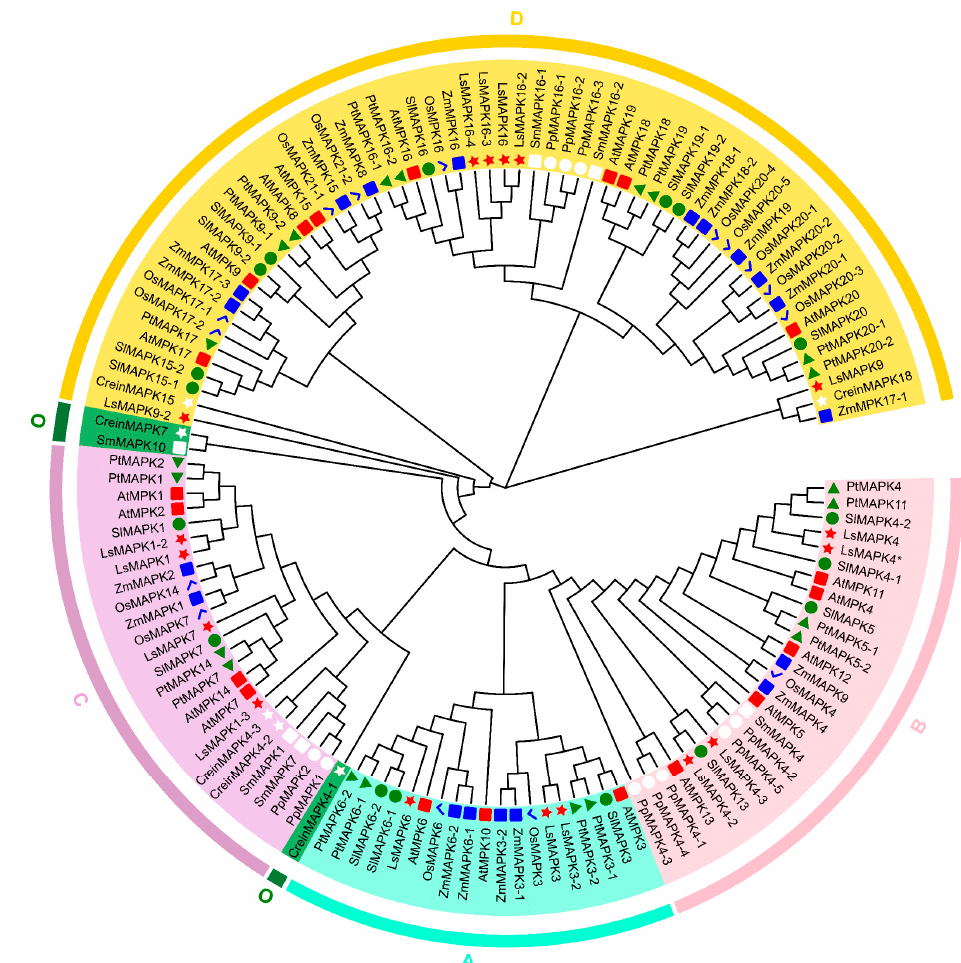
Figure 3. Phylogenetic relationships of the MAPK gene family from Physcomitrella patens ( PpMAPKs ), Chlamydomonas reinhardtii ( CreinMAPKs ), Selaginella moellendorffii ( SmMAPKs ), Arabidopsis thaliana ( AtMAPKs ), Oryza sativa ( OsMAPKs ), Zea mays ( ZmMAPKs ), Solanum lycopersicum ( SlMAPKs ), Populus trichocarpa ( PtMAPKs ), and Lactuca sativa ( LsMAPKs ). Distinct color blocks represent different groups. The different shapes and colors of the symbols indicate different species.